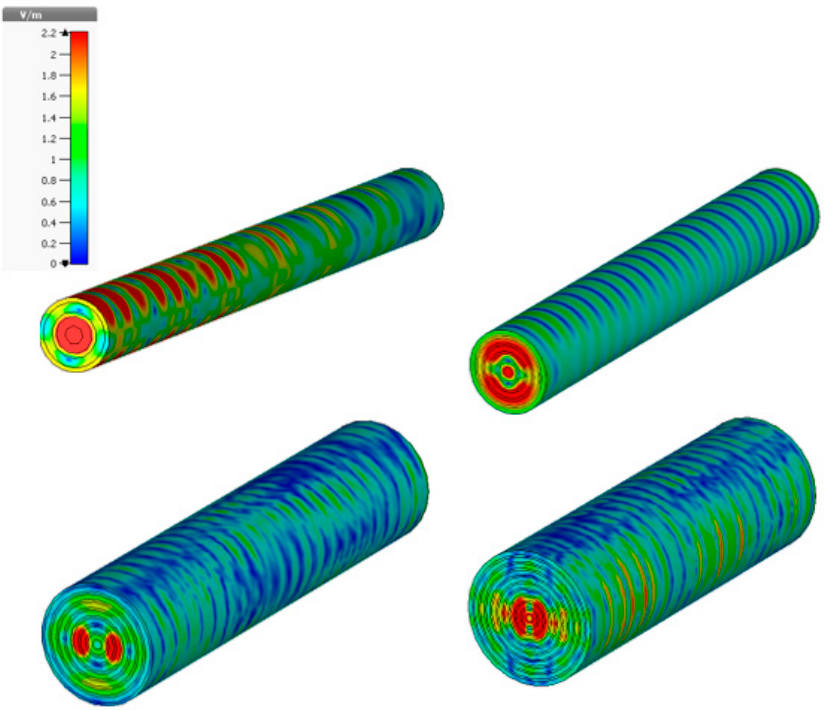
Figure 11. Electric field distribution inside wet poplar wood with different values of the numbers of growth rings with 50% permittivity variation at 3 GHz. Dielectric constant values were used with 28% moisture content according to [27].